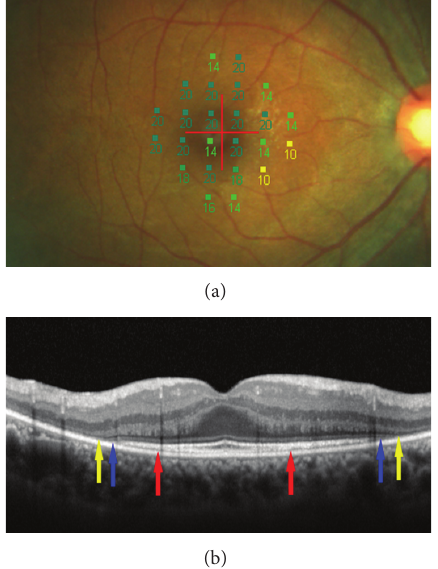
Figure 1: Microperimetric map and spectral-domain optical coher- ence tomographic (SD-OCT) image of an eye with retinitis pigmen- tosa (42-year-old woman). (a) Microperimetric map image. A total of 24 stimulus locations covering the central 10 ∘ field were tested. The mean retinal sensitivity at the 24 locations is 17.3dB. The best corrected visual acuity was 1.0. (b) SD-OCT image of a vertical scan. In addition to photoreceptor inner/outer segment (IS/OS) junction line, the external limiting membrane (ELM) and cone outer segment tips (COST) lines are clearly seen on the SD-OCT image. Red arrows indicateendpointsoftheCOSTline.Bluearrowsindicateendpoints of the IS/OS line and yellow arrows end points of the ELM line. The lengths of the COST, IS/OS, and ELM lines were computed at 2272, 4629, and 4930 𝜇 m, respectively. Note that the line length was the longest in the ELM, followed by the IS/OS and COST. The direction of photoreceptor impairment is from outside toward inside.